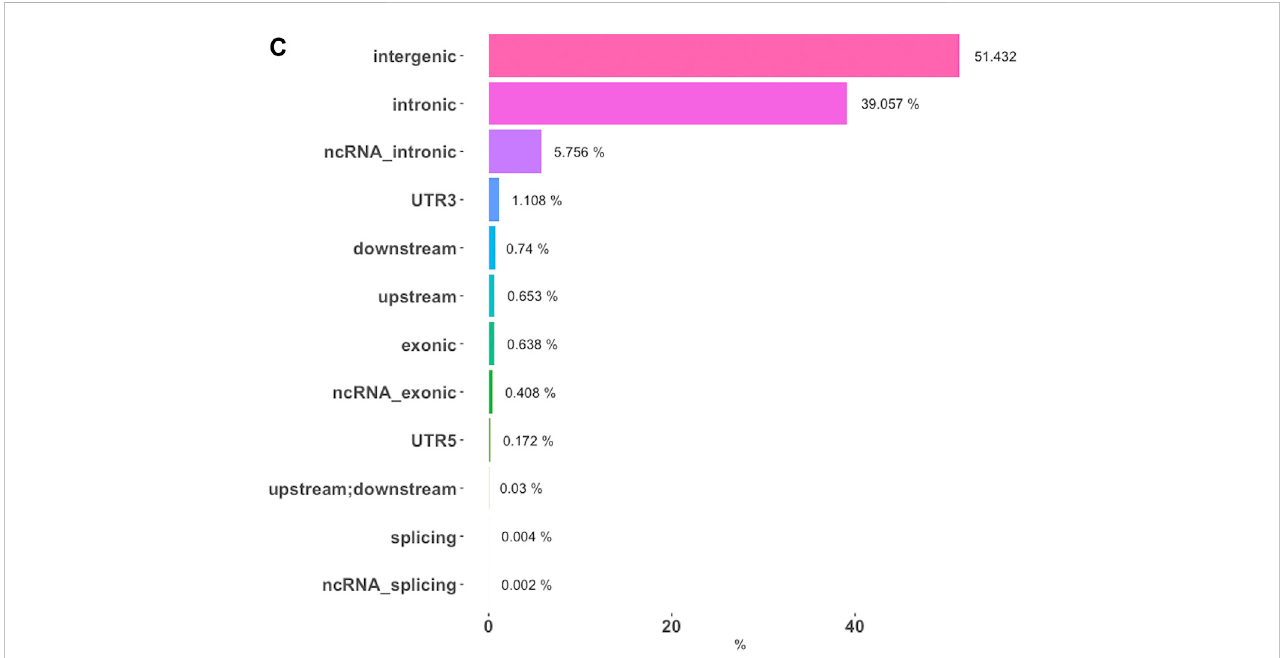
FIGURE 2 Characterization of the African AIMs identi fi ed in this study. (A) Selection of the ancestry informative markers (AIMs) common to the different sets of continental African AIMs to generate the fi nalset of 46,737 African AIMs. (B) Distribution of the number of African AIMs in1 Mb chromosomal windows across chromosomes.Althoughsomewindowscontainamuchhighercount,the y -Axisiscappedat300SNPstovisualizemostofthepeakswhichcontainlessthan 300 SNPs per window. The location of AIMs from this set that appear in the GWAS database as associated with cancer phenotypes are shown on the karyotype plot (nine ontologies are indicated as separate colors). (C) Distribution of African AIMs across different genomic regions.